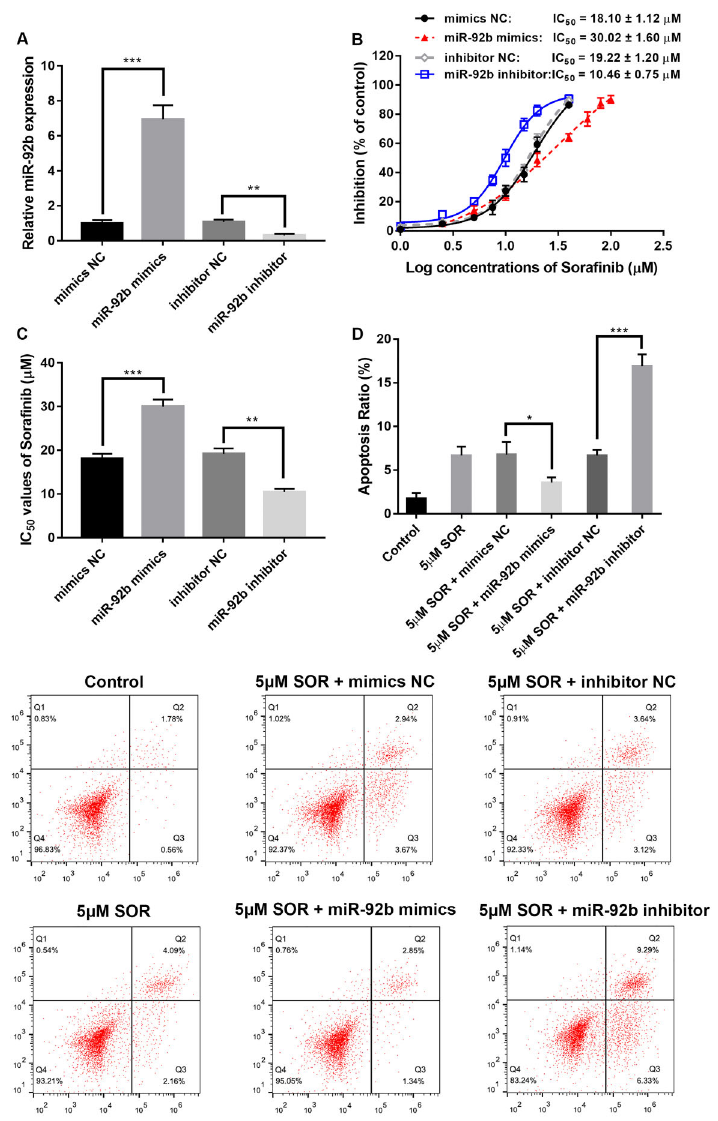
Figure 2. Down-regulation of miR-92b increases sorafenib (SOR) sensitivity in HepG2/SOR cells. A , qRT-PCR analysis of miR-92b expression at different transfections. B and C , Rates of inhibition and half maximal inhibitory concentration (IC 50 ) values of SOR in HepG2/SOR cells. D , Flow cytometry measured apoptosis rates of HepG2/SOR cells at different transfections and incubation with SOR (0.5 m M). Data are reported as means ± SD. *P o 0.05, **P o 0.01, ***P o 0.001 (ANOVA). NC: negative